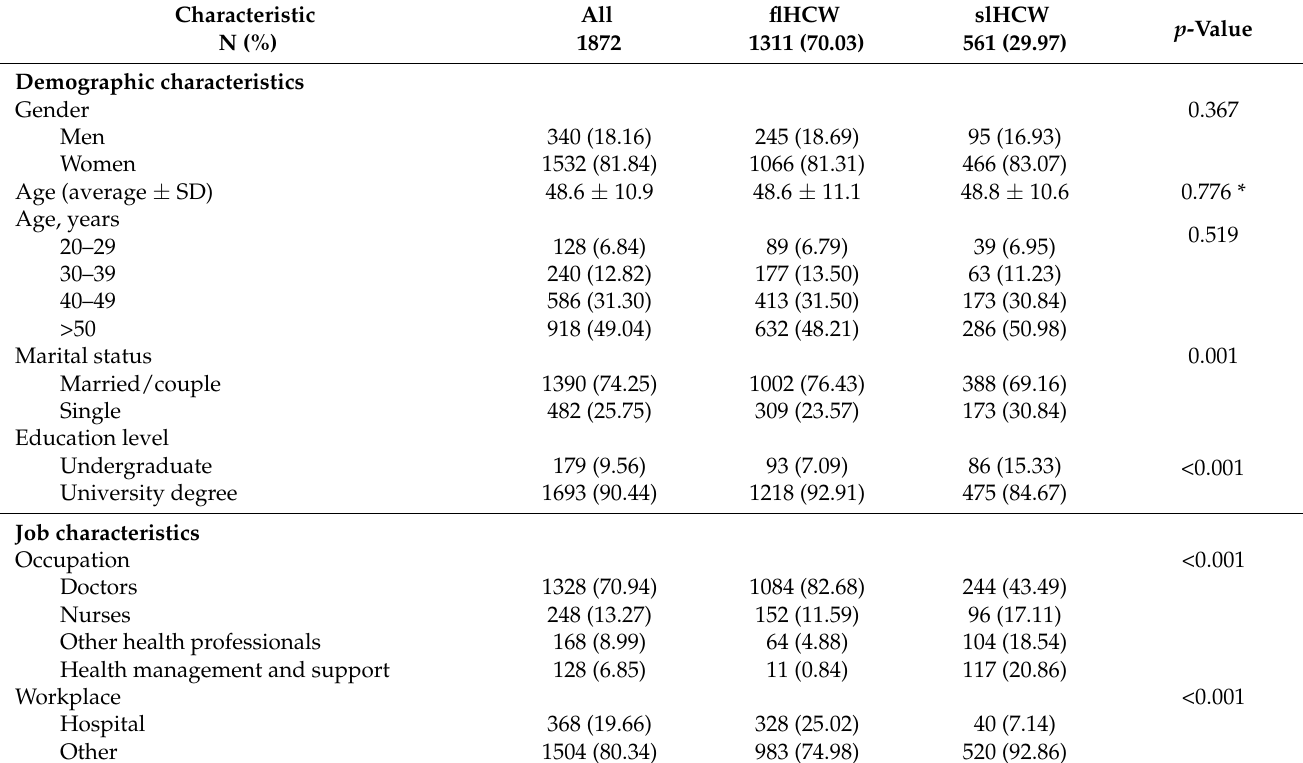
Table 1. General characteristics of the